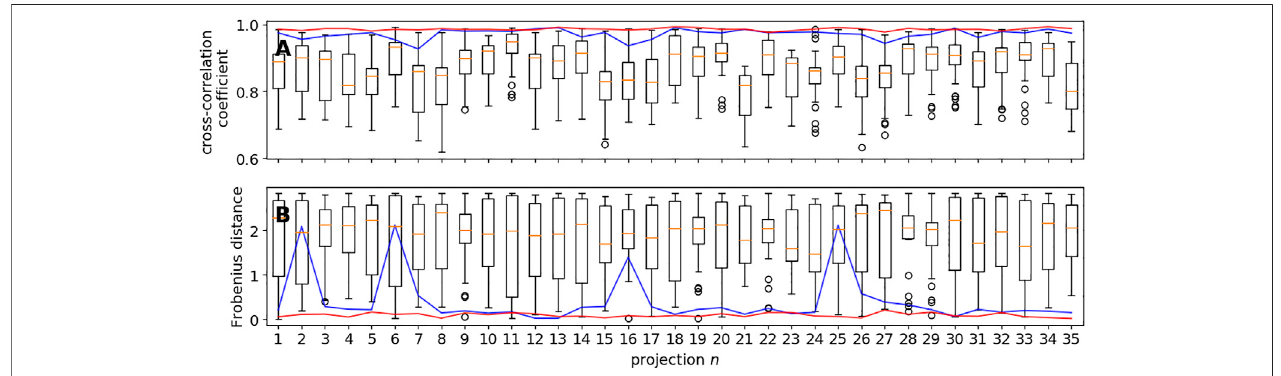
FIGURE 3 | Global vs. local sampling of orientational parameters. Shown are the cross-correlation coef fi cients (panel A) and Frobenius distances (panel B) for each ofthe 35inputdirections achieved withlocalsamplingbasedon theMHalgorithmand global samplingusing aregular discretizationofthe3-hemisphere.The blue curve shows the results obtained with the coarsest covering based on 330 unit quaternions; the red curve shows the results obtained with a fi ner covering (2,460 quaternions). The box plots show the variability within 30 trials of MH starting from random